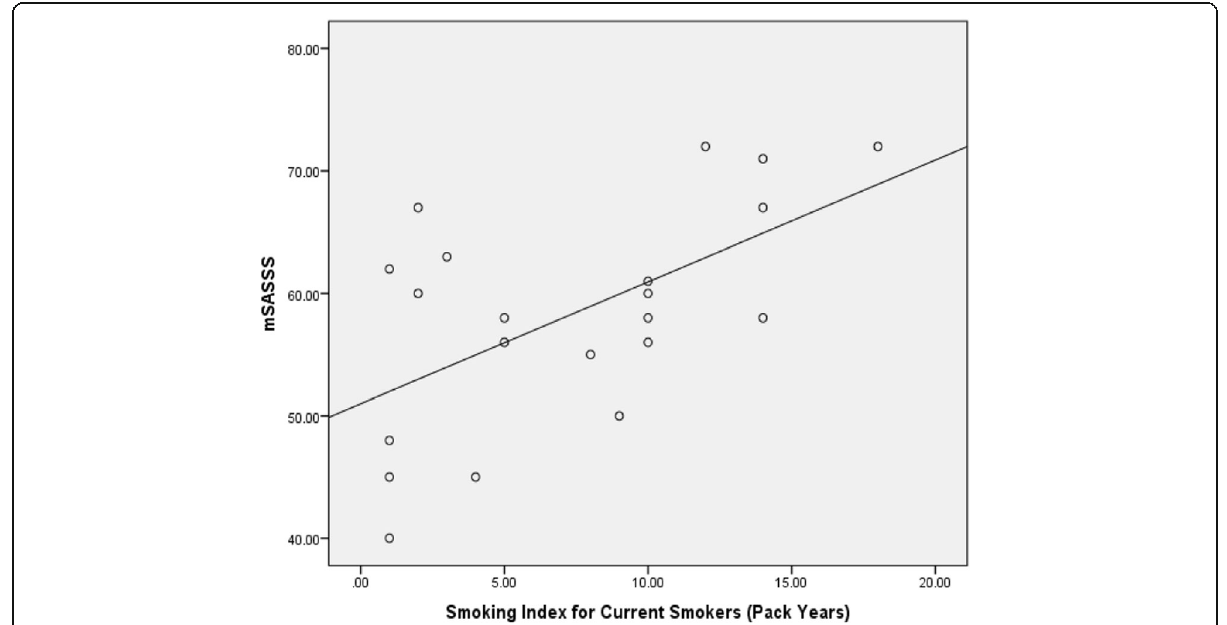
Fig. 3 Correlation between smoking index and mSASS in AS patients. mSASSS: modified Stoke Ankylosing Spondylitis Spine